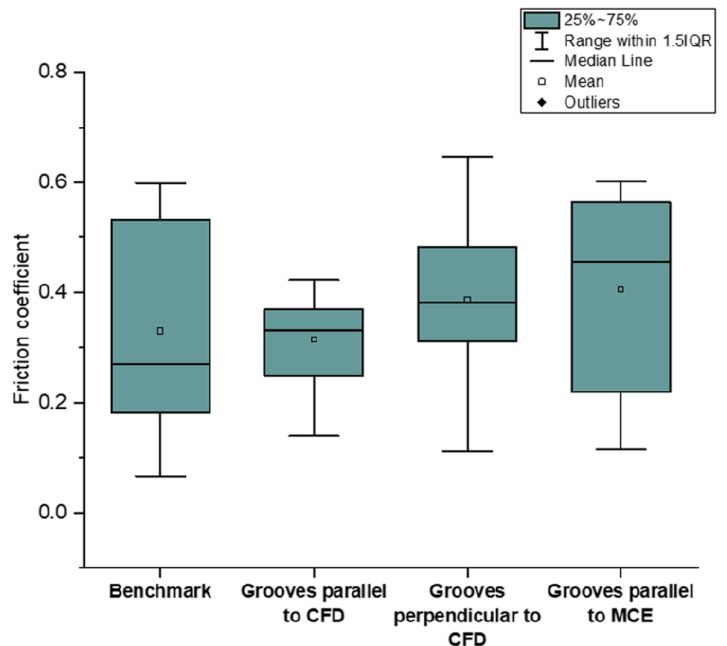
Figure 15. Average value of the coefficient of friction calculated from the cutting forces data for all types of machining cases benchmark, grooves parallel to CFD, grooves perpendicular to CFD and grooves parallel to MCE [80].